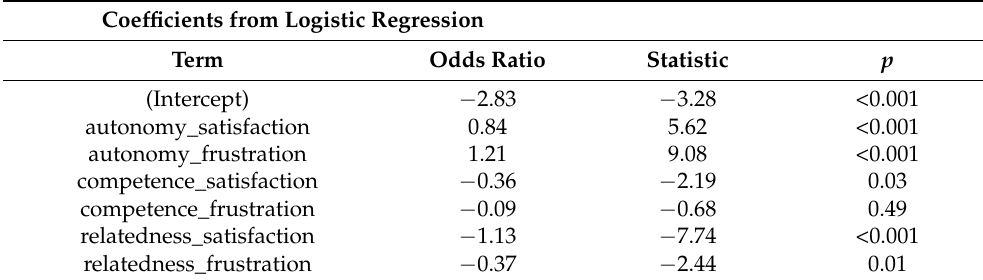
Table 5. Logistic regression of the three psychological needs and “decision to get vaccinated”.